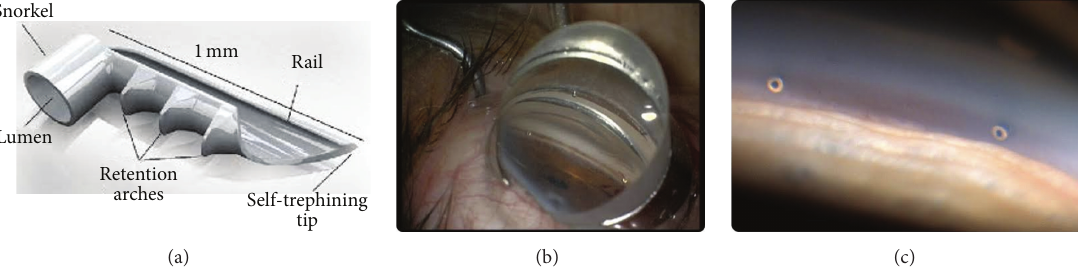
Figure1:IllustrationoftheiStentwithdimensionsandtechnicalspecifications(a);intrasurgicalviewofthetrabecularmeshworkwithadirect gonioscopy lens (b); flipped view of 2 inserted iStents under gonioscopy (c). ((a) and (b), courtesy of Glaukos Corporation; (c), courtesy of Matt Poe,